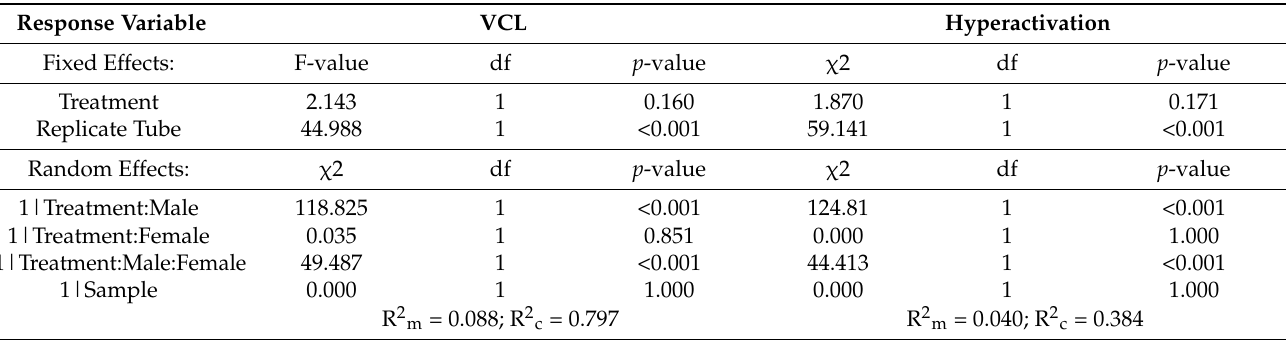
Table 3. Linear mixed model (LMM) for sperm swimming velocity (VCL) and generalized mixed model (GLMM) for the proportion of hyperactivated sperm cells, testing for the consistency of male–female compatibility effect in different sperm treatments (180 min in follicular fluid vs. 300 min in serum, see Results). Models included treatment and replicate tube as fixed effects and interactions of treatment:male, treatment:female, treatment:male:female, and repeated measurement of